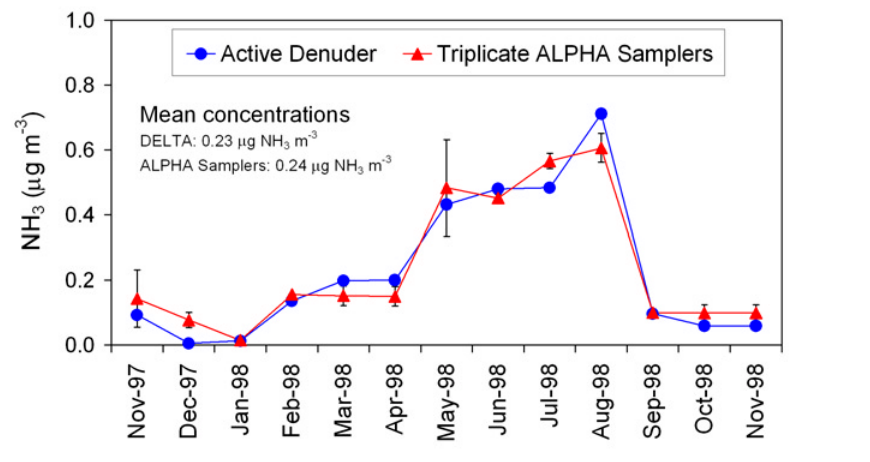
FIGURE 6 . Intercomparison of NH 3 measurement results by ALPHA sampler and active denuder system at Monte Bondone, Italy (ECOMONT project). Each data point for the ALPHA sampler results represent the mean ± SD of replicate samples (n=3).